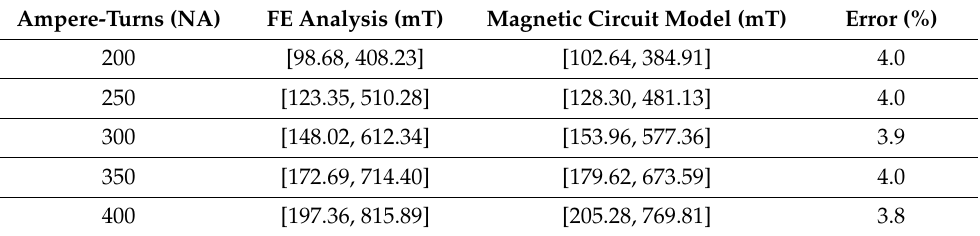
Table 4. The comparison of finite element simulation and modeling calculation results of axial multi-coil